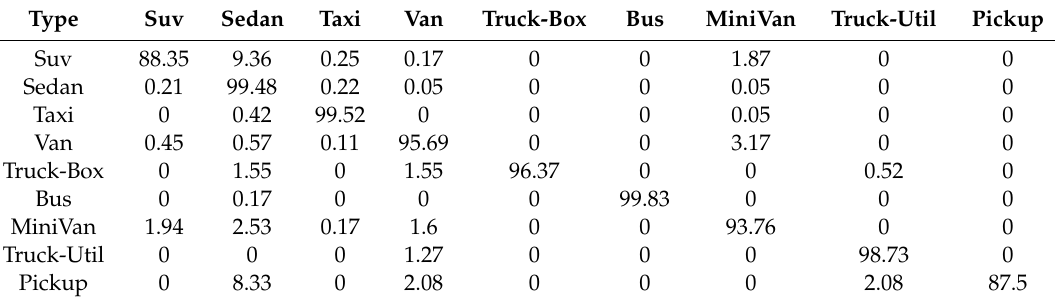
Table 2. The confusion matrix of the improved YOLO algorithm (unit